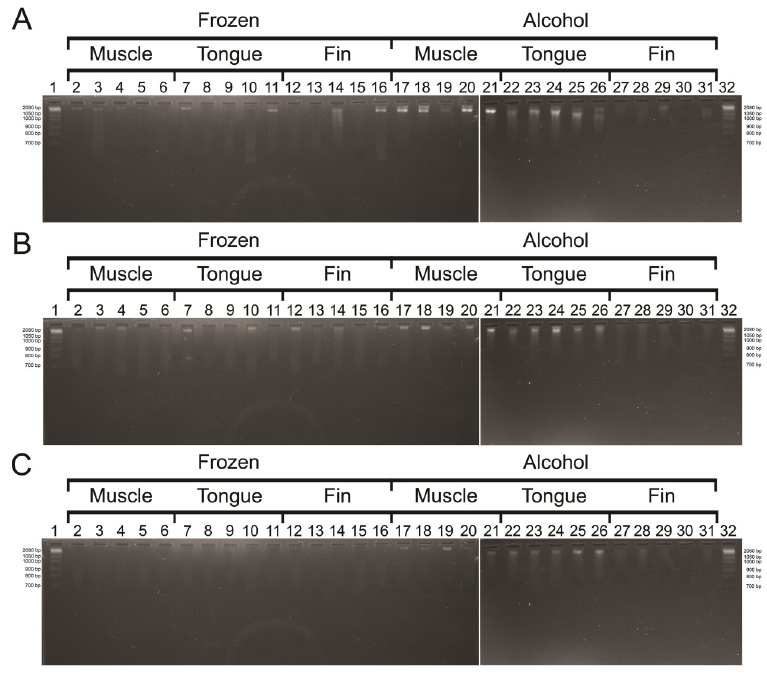
Fig 2. Electrophoresis of DNA isolated from L . purpureus by three different methods. A: saline (NaCl) protocol, B: Wizard 1 Genomic kit—Promega, C: Phenol-chloroform-isoamyl alcohol. Lanes 1 and 32: 2,8 kb ladder molecular size markers. A white line indicates that lanes 20 and 21 are of the same